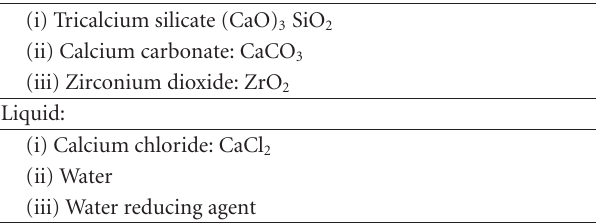
Table 2: Composition (in g/L) of the Dulbecco’s phosphate bu ff - ered saline used for the study.